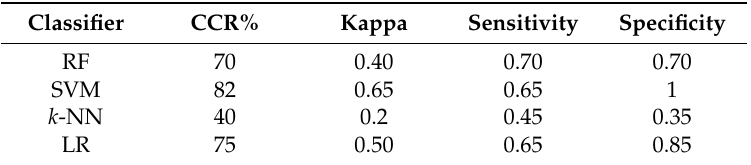
Table 4. Model performance for identification of different diet on validation